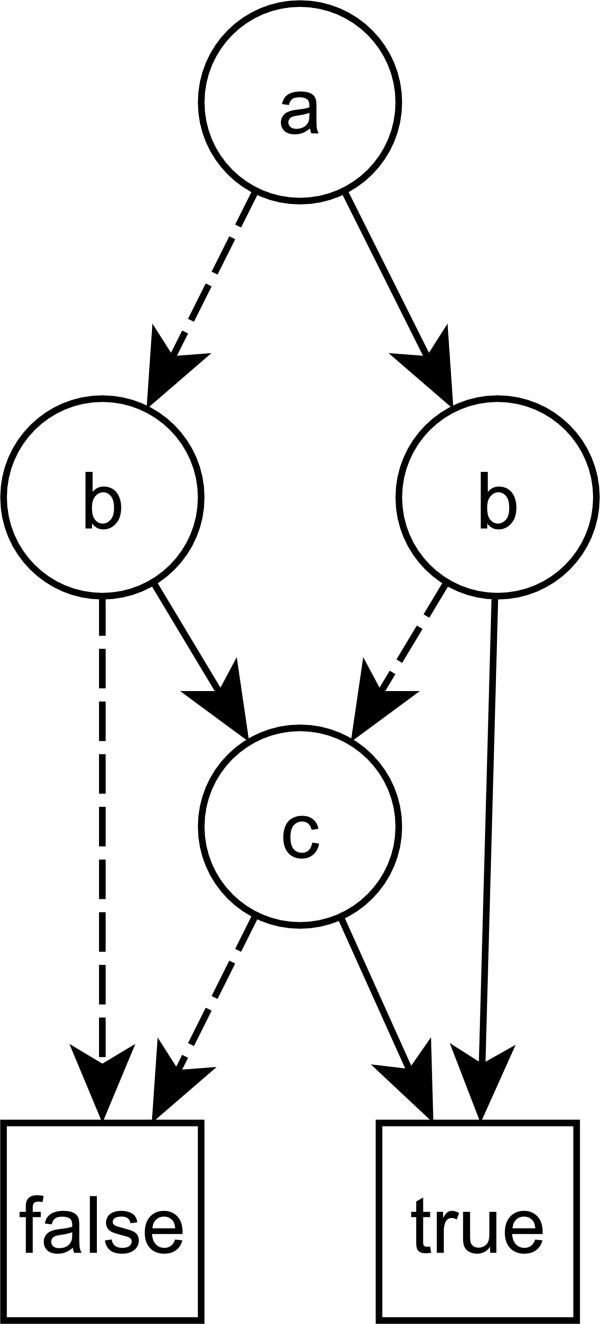
A binary decision diagram for the function (a OR b) AND (b OR c) AND (a OR c). Evaluation starts at the node “a”, which does not feature any ingoing connections from other nodes. If the value of the node is 1, the solid line is followed, if it is 0, the dashed line is followed. For the input values a = c = 1 and b = 0 one would go down from the “a” node to the right “b” node, on to the “c” node and finally along the solid line to the “true” node. This corresponds to (1 OR 0) AND (0 OR 1) AND (1 OR 1) = 1 AND 1 AND 1 = 1 (true).